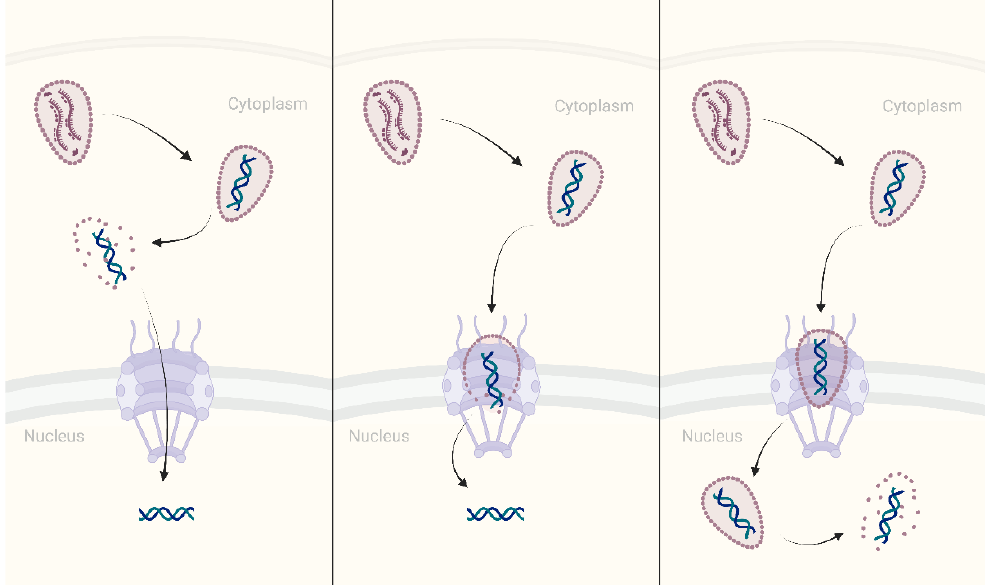
Figure 4. Models of HIV-1 capsid uncoating. Capsid uncoating starts almost immediately after HIV-1 core enters the cytoplasm following virus–cell membrane fusion (left panel). Capsid uncoating initiates when the virus core is docked on the NPC (central panel). The intact or nearly intact HIV-1 core penetrates through the NPC and uncoating occurs near sites of integration in the nucleus (right panel).